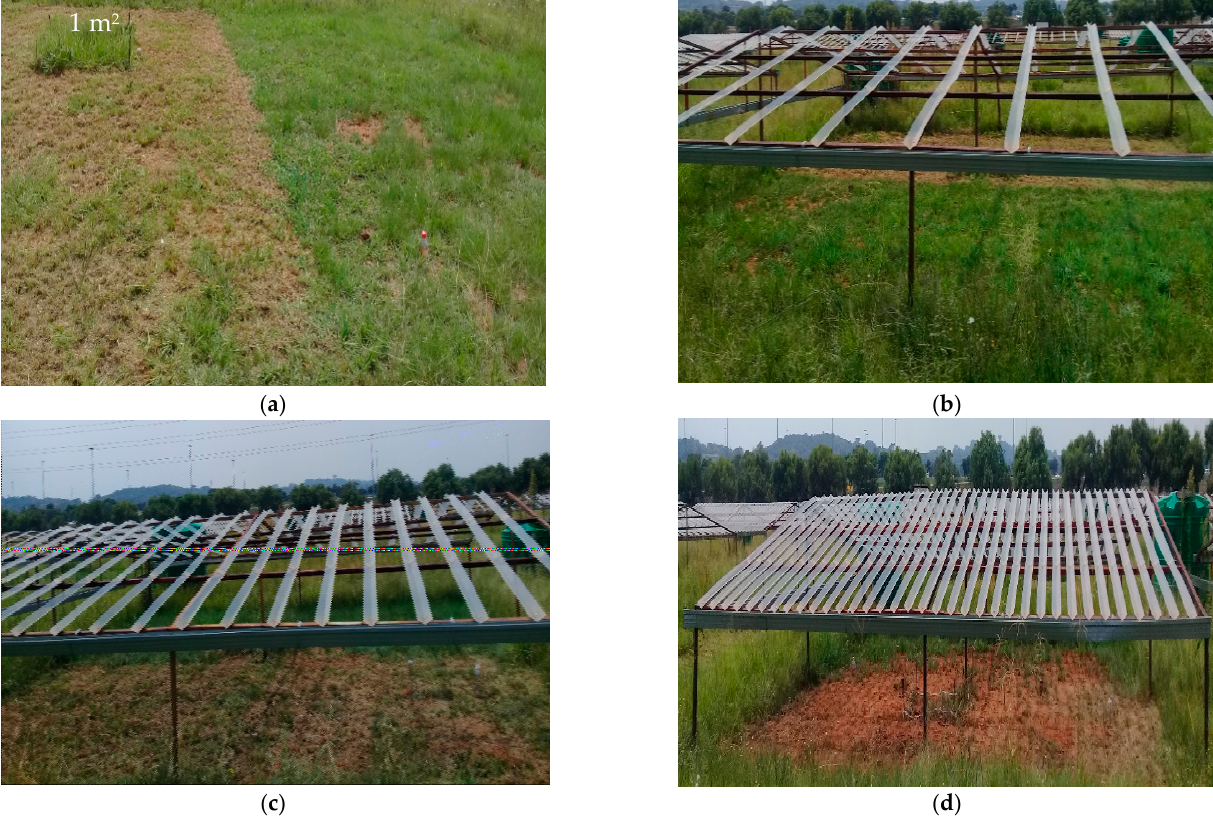
Figure 2. Experimental design: ( a ) 0% rainfall reduction, ( b ) 15% rainfall reduction, ( c ) 30% rainfall reduction and ( d ) 60% rainfall reduction.